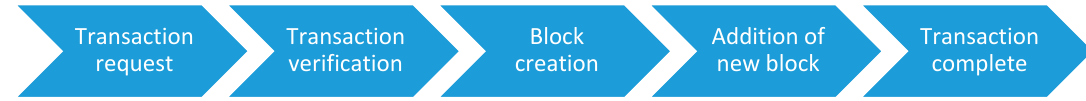
Figure 2. Blockchain technology: process. Source: Lakshmi and Sricharan, 2019, p. 1784 [29].